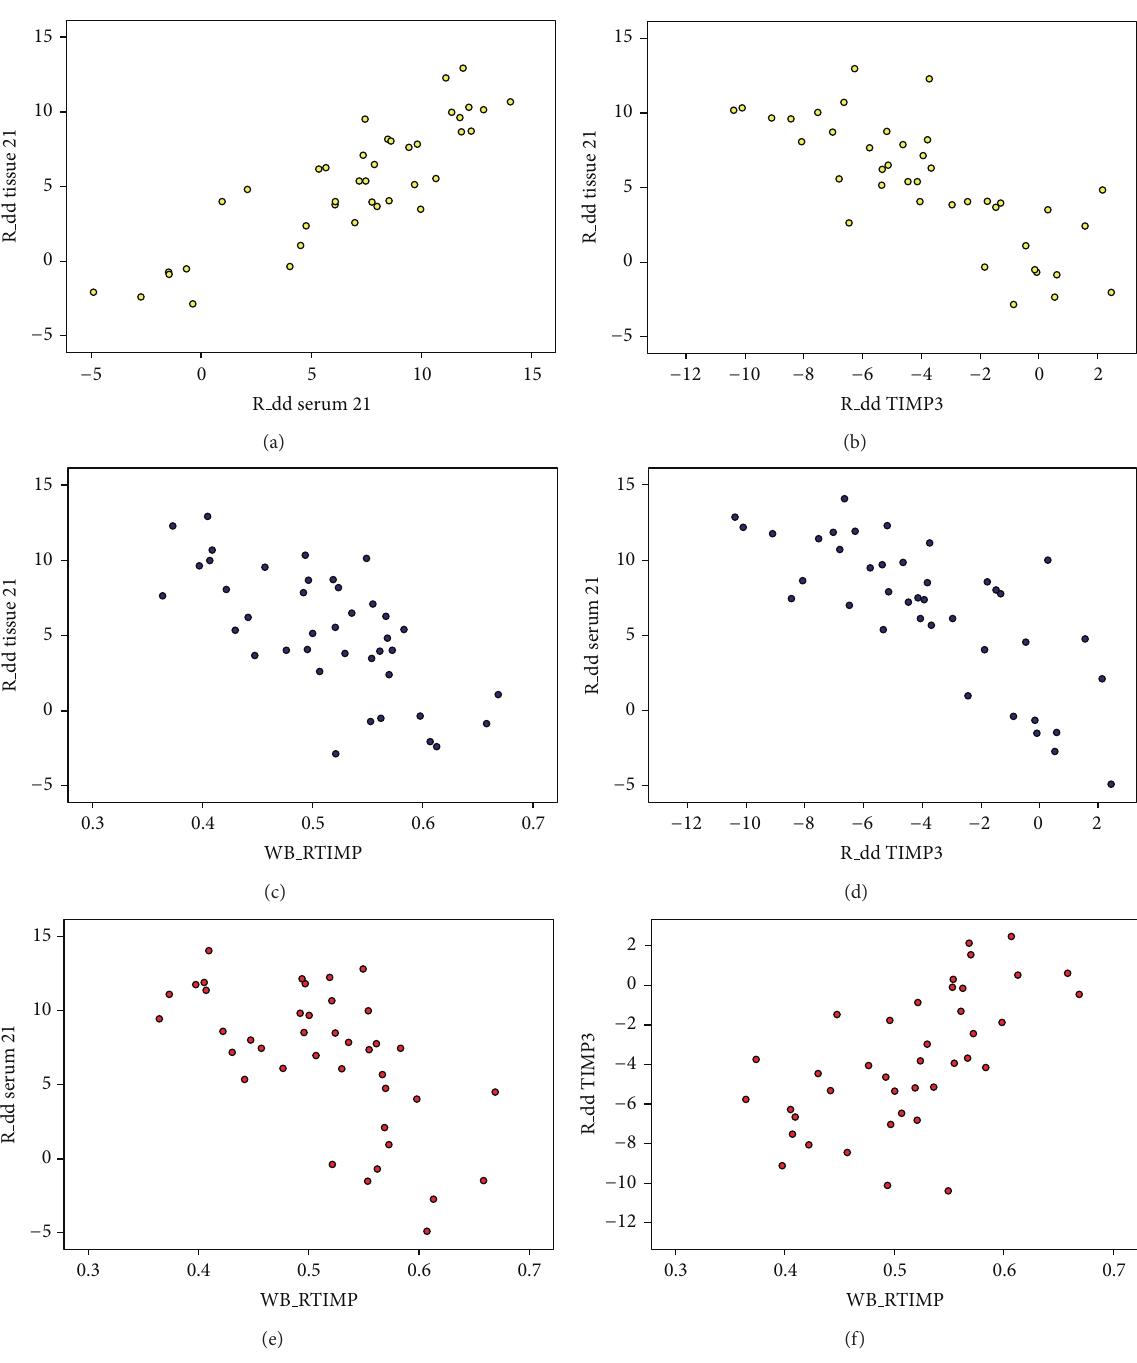
Figure 3: (a) miR-21 transcription in volume of breast tissue and corresponding serum levels in patients with significant correlation, Pearson correlation (positive correlation, correlation coefficient = 0.866, P < 0.05). (b) Different clinical invasions of breast tissue in the transcription miR-21andTIMP3weresignificantlycorrelated(negativecorrelation,correlationcoefficient= − 0.778, P < 0.05).(c)Differentclinicalinvasion of breast tissue in volume of miR-21 transcription and TIMP3 protein expression was significantly correlated (negative correlation, correlation coefficient = − 0.692, P < 0.05). (d) miR-21 serum levels and breast tissue volume of TIMP transcription were significantly correlated (negative correlation, correlation coefficient = − 0.762, P < 0.05). (e) miR-21 serum levels and TIMP breast tissue levels of protein expressions were significantly correlated (negative correlation, correlation coefficient = − 0.625, P < 0.05). (f) Different clinical invasions of breast tissue levels of TIMP3 transcription and protein expression were also correlated (positive correlation, correlation coefficient = 0.616, P <